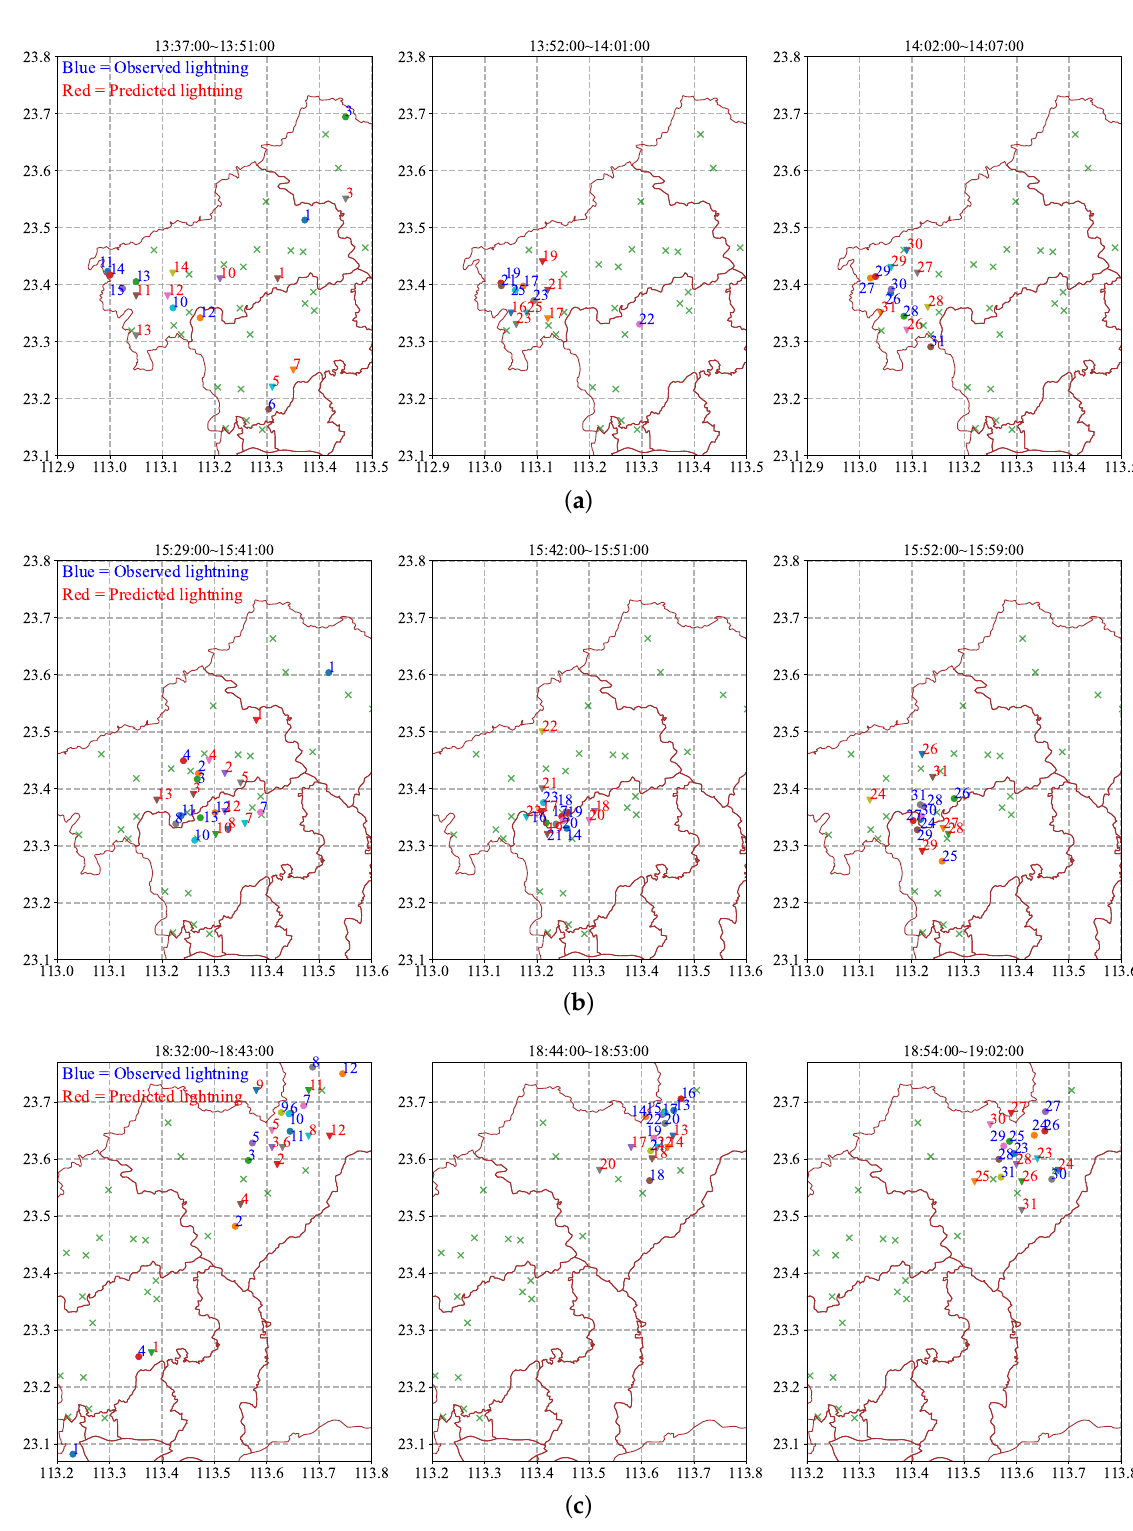
Figure 21. Three cases in the operation of lightning warning system (The green mark “x” represents the distribution of the atmospheric electric field meters, the blue numbers represent the actual center of flashes, the red numbers represent the predicted positions, and the numbers themselves represent the time elapsed compared to the start). ( a ) A thunderstorm that occurred on 2 May 2021 from 13:37 to 14:07; ( b ) A thunderstorm that occurred on 10 June 2021 from 15:29 to 15:59; ( c ) A thunderstorm that occurred on 17 August 2021 from 18:32 to